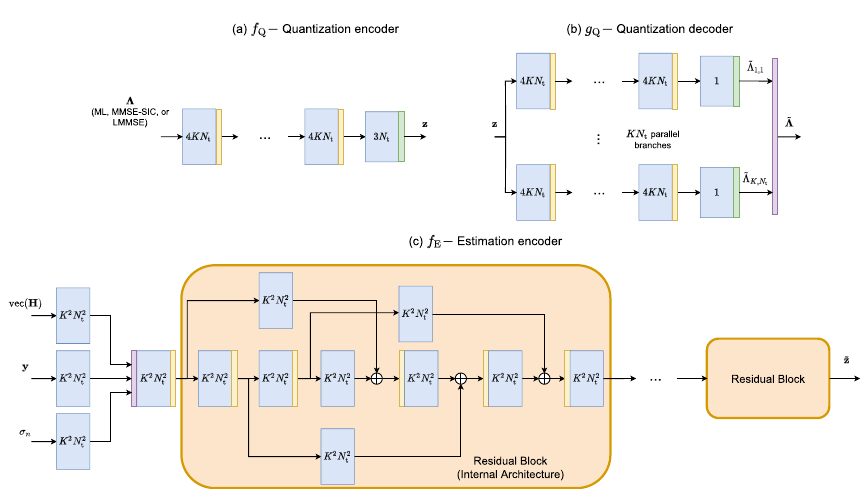
Fig. 2 Internal architecture for the deep neural networks in Figure 1. The blue blocks are fully connected layers, with the output dimension displayed. The yellow and green blocks represent the relu and tanh activations, respectively, while the purple block represents a concatenation operator. a The architecture of the quantization encoder f Q . b The architecture of the quantization decoder g Q . c The architecture of the estimation encoder f E , composed of (potentially) multiple residual blocks. The internal architecture of a single residual block is shown